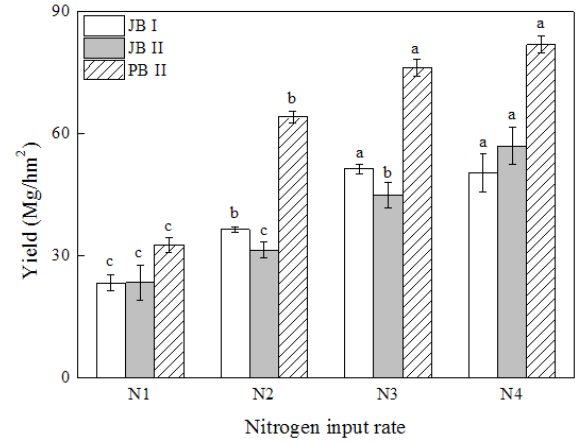
Figure 3. Cabbage yields of JB cultivar in year I (JB I) and II (JB II) and PB cultivar in year II (PB II) response to different chemical fertilizer N application rates. Treatments N1, N2, N3 and N4 received 0, 80, 140, and 200 kg · N · ha −1 in the growth season, respectively. Different letters indicate significantly differences among different N input rates of the same cultivar at the p < 0.05.